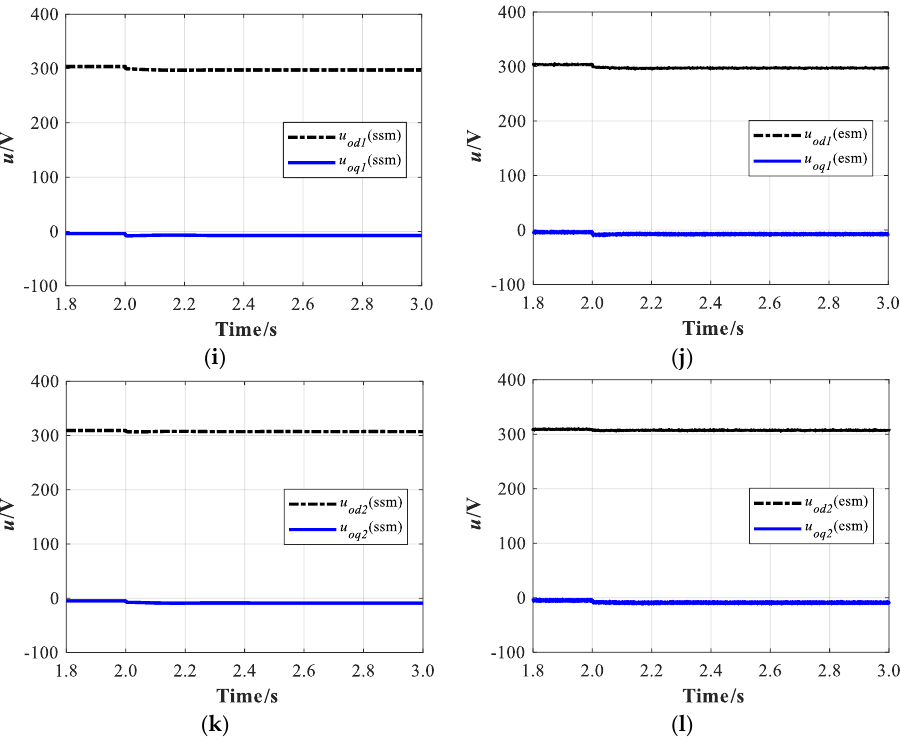
Figure 11. Transient impact of the electrical simulation model and small-signal model with load perturbation: the intermediate control signals in the VSG control system: ( a ) The i fd and i fq of the VSG #1 in ssm; ( b ) The i fd and i fq of the VSG #1 in esm; ( c ) The i fd and i fq of the VSG #2 in ssm; ( d ) The i fd and i fq of the VSG #2 in esm; ( e ) The i od and i oq of the VSG #1 in ssm; ( f ) The i od and i oq of the VSG #1 in esm; ( g ) The i od and i oq of the VSG #2 in ssm; ( h ) The i od and i oq of the VSG #2 in esm; ( i ) The u od and u oq of the VSG #1 in ssm; ( j ) The u od and u oq of the VSG #1 in esm; ( k ) The u od and u oq of the VSG #2 in ssm; ( l ) The u od and u oq of the VSG #2 in esm.